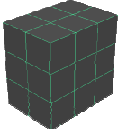
Figure 6. Modeling the Head (see text for